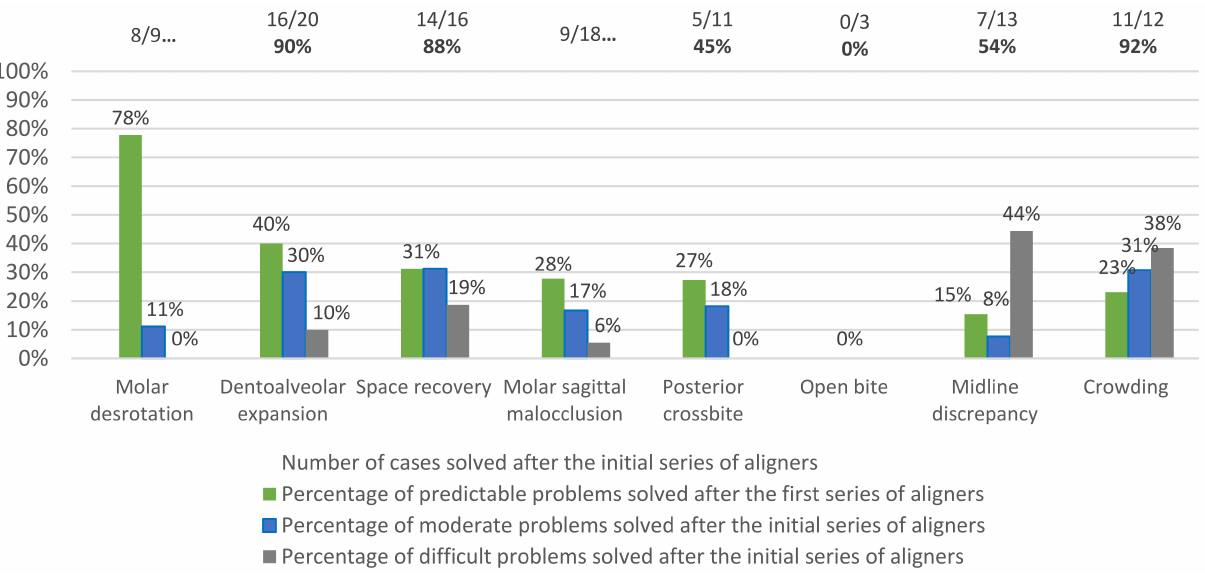
Figure 1. Percentages of malocclusion traits corrected after the first series of aligners according to the problem classification. Table 6. The relationships between the initially established degree of complexity (i.e., predictable, intermediate, or difficult corrections) and the percentage of the interceptive malocclusion traits being solved with the first series of aligners. One-sided Cochran–Armitage trend